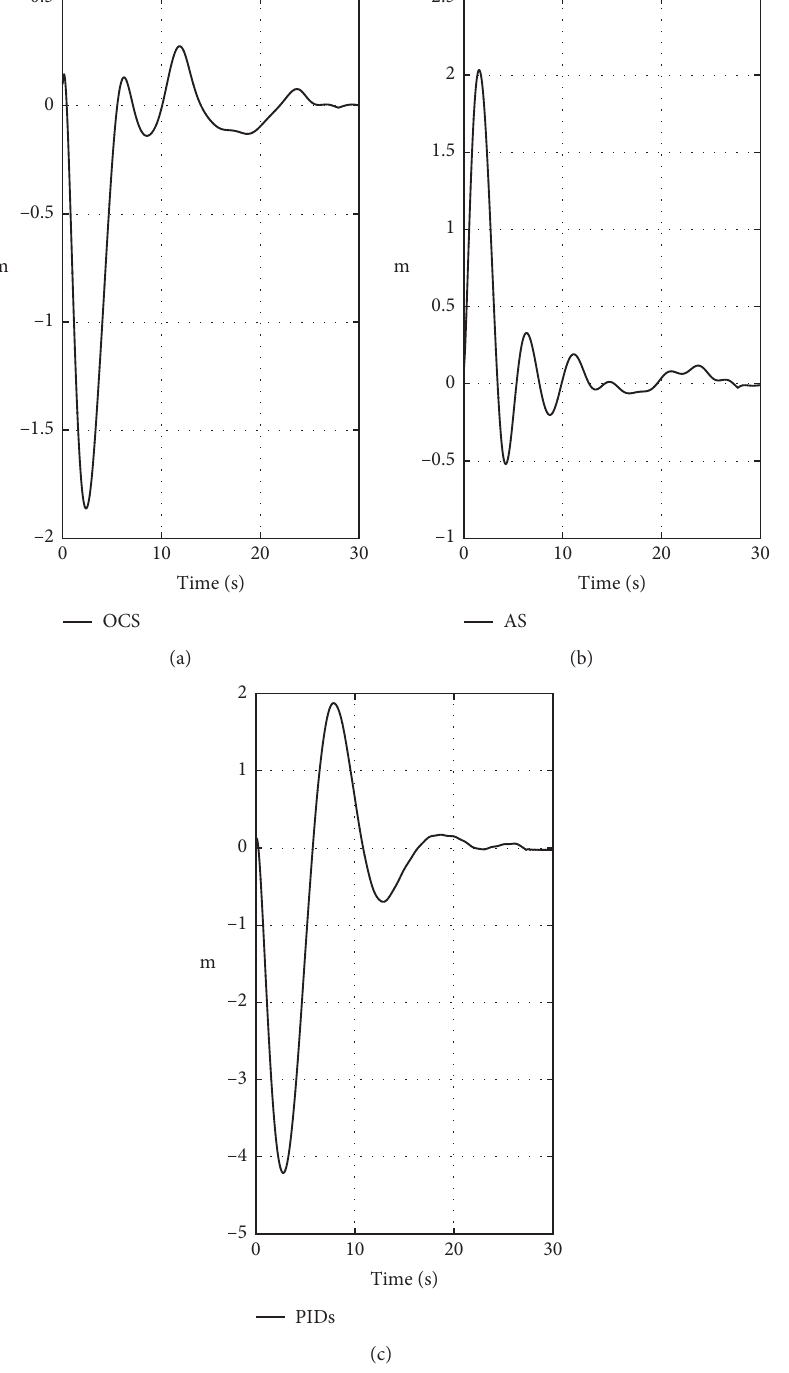
r of strategies OCS, PID, and AS, when the system is perturbed by a